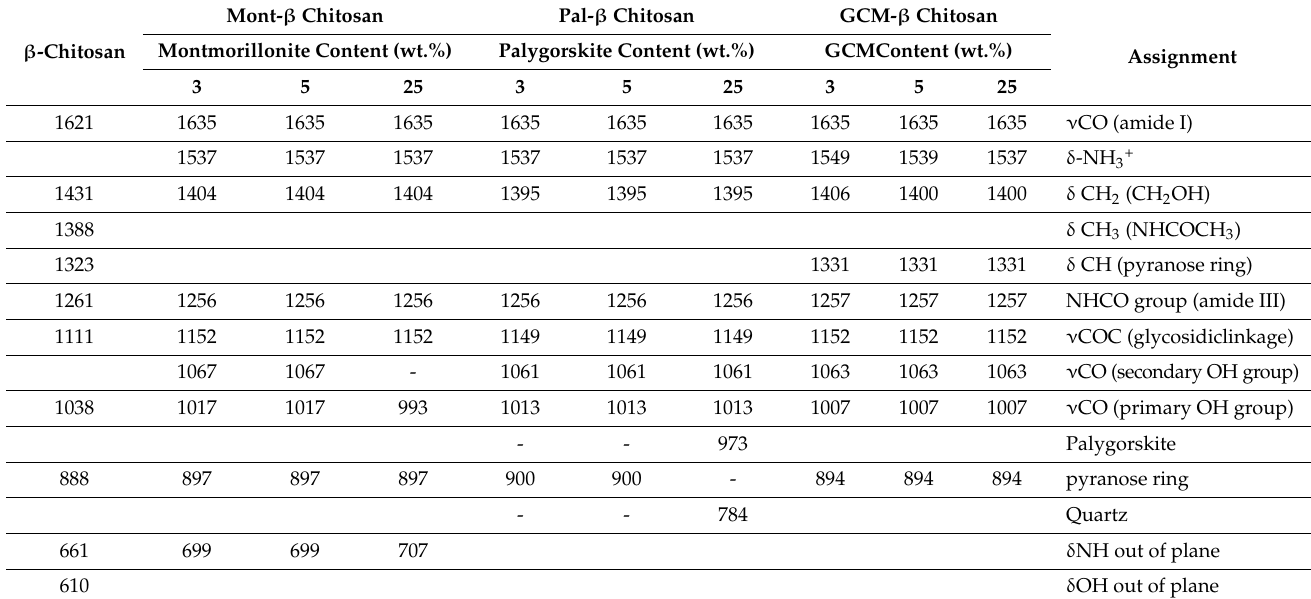
Table 2. Frequencies (cm − 1 ) and assignments of FT-IR bands of the spectra of pure and filler-containing β -chitosan- based